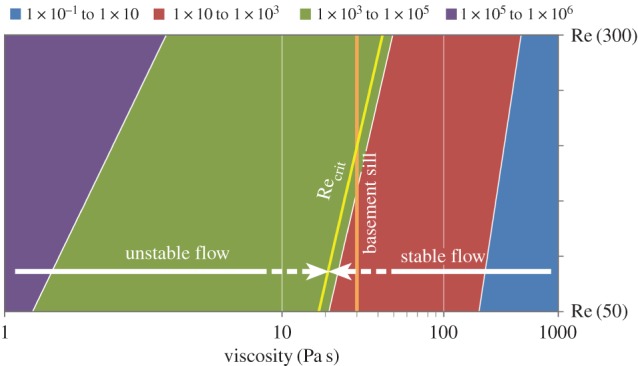
Domain map for modelled Basement Sill magmas (1 < η < 104 Pa s) as a function of along-strike variation in Sill within the Wright Valley region (50–300 m, [27]). Reynolds numbers (10−1 < Re < 106) scale with intrusion thickness and magma viscosity. Vertical line shows calculated melt viscosity of the Basement Sill for reference. Flow instability (static eddy formation) is predicted at uneven contacts between Sill and country rock where Recrit > around 2000 (this model and [51]). For a melt viscosity of approximately 30 Pa s (Basement Sill) this corresponds to a Sill thickness of approximately 200 m.